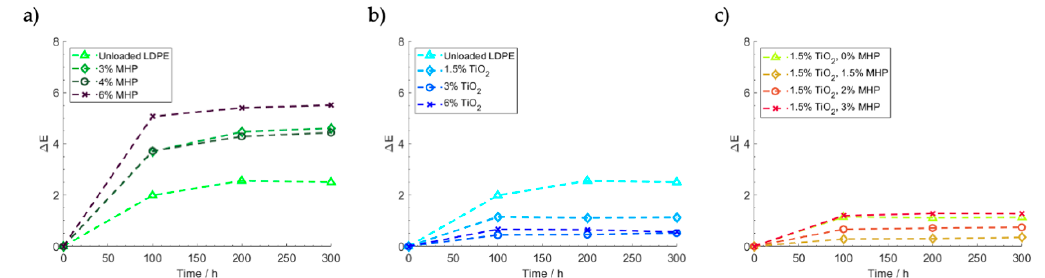
Figure 9. Influence of TiO 2 and MHP content on color change of LDPE samples during sunlight exposure: ( a ) MHP, ( b ) TiO 2 , and ( c ) MHP and 1.5 wt.% TiO 2 .